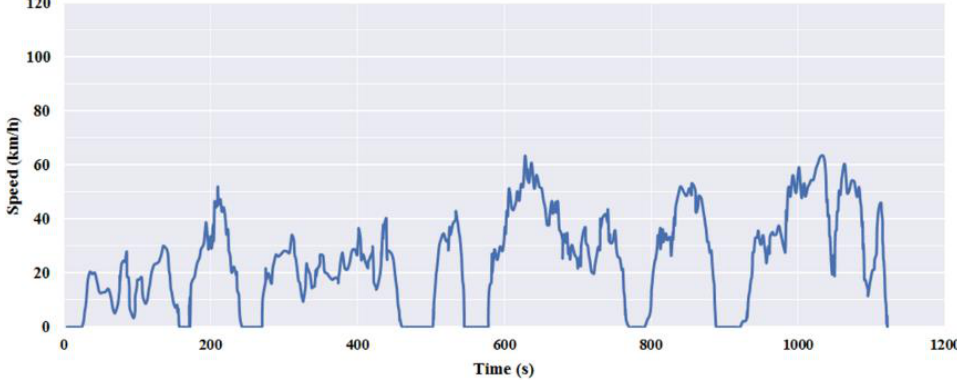
Figure 9. The localized vehicle driving cycle in Tianjin.